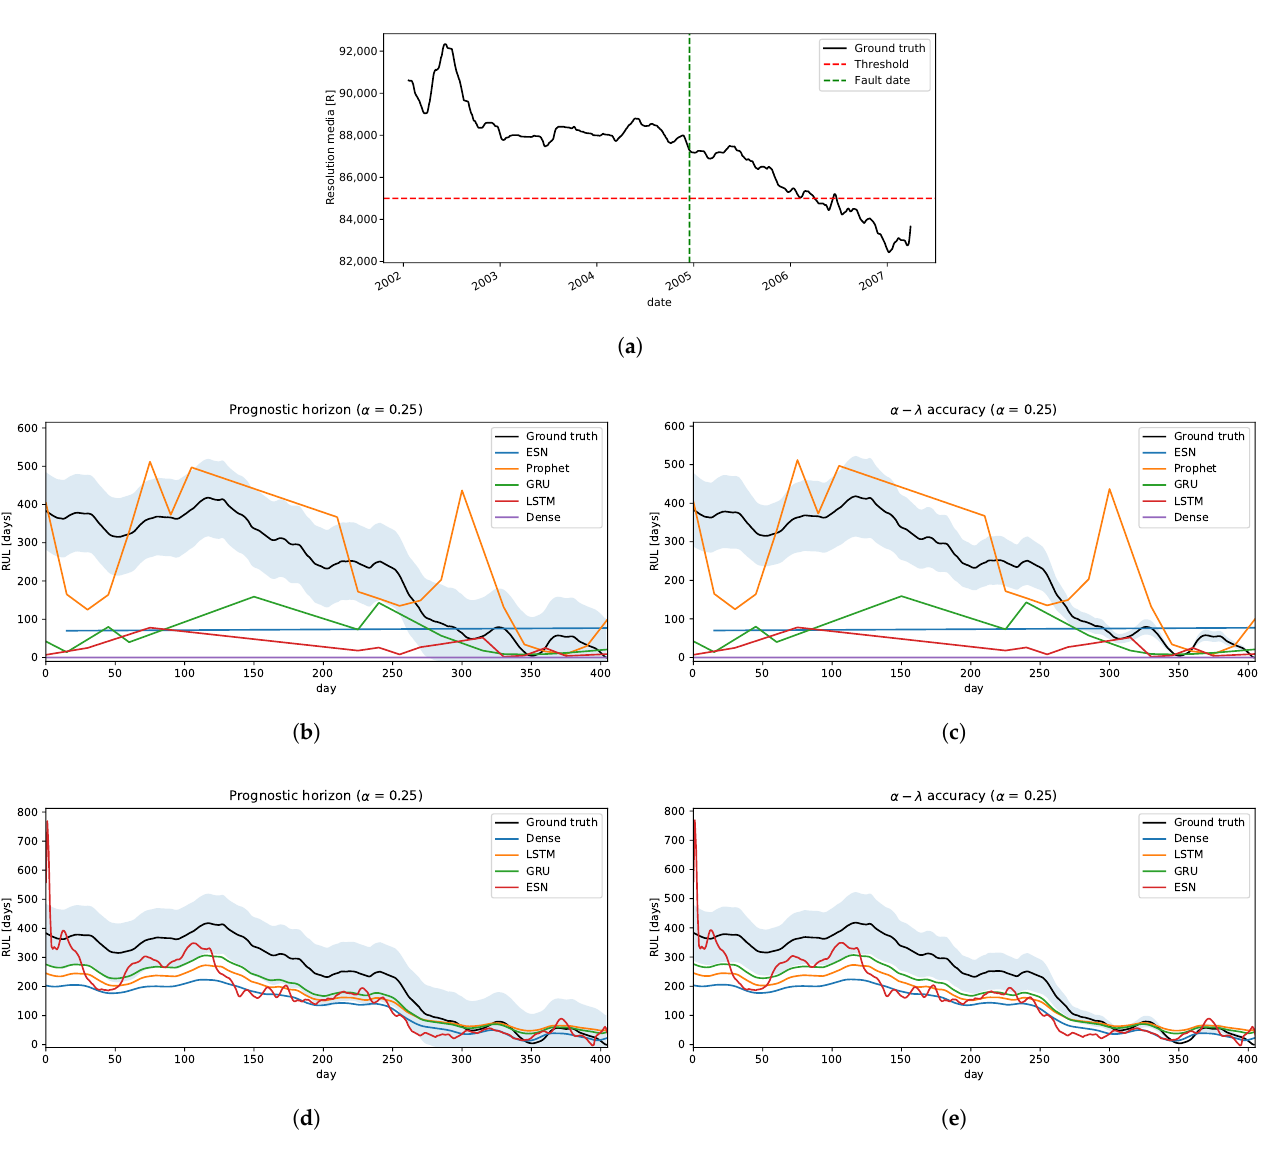
Figure 15. The Camera Resolution prognostic. ( a ) Testing: Resolution media trajectory. ( b ) Strategy A: The prognostic horizon metric. ( c ) Strategy A: The α – λ accuracy metric. ( d ) Strategy B: The prognostic horizon metric. ( e ) Strategy B: The α – λ accuracy